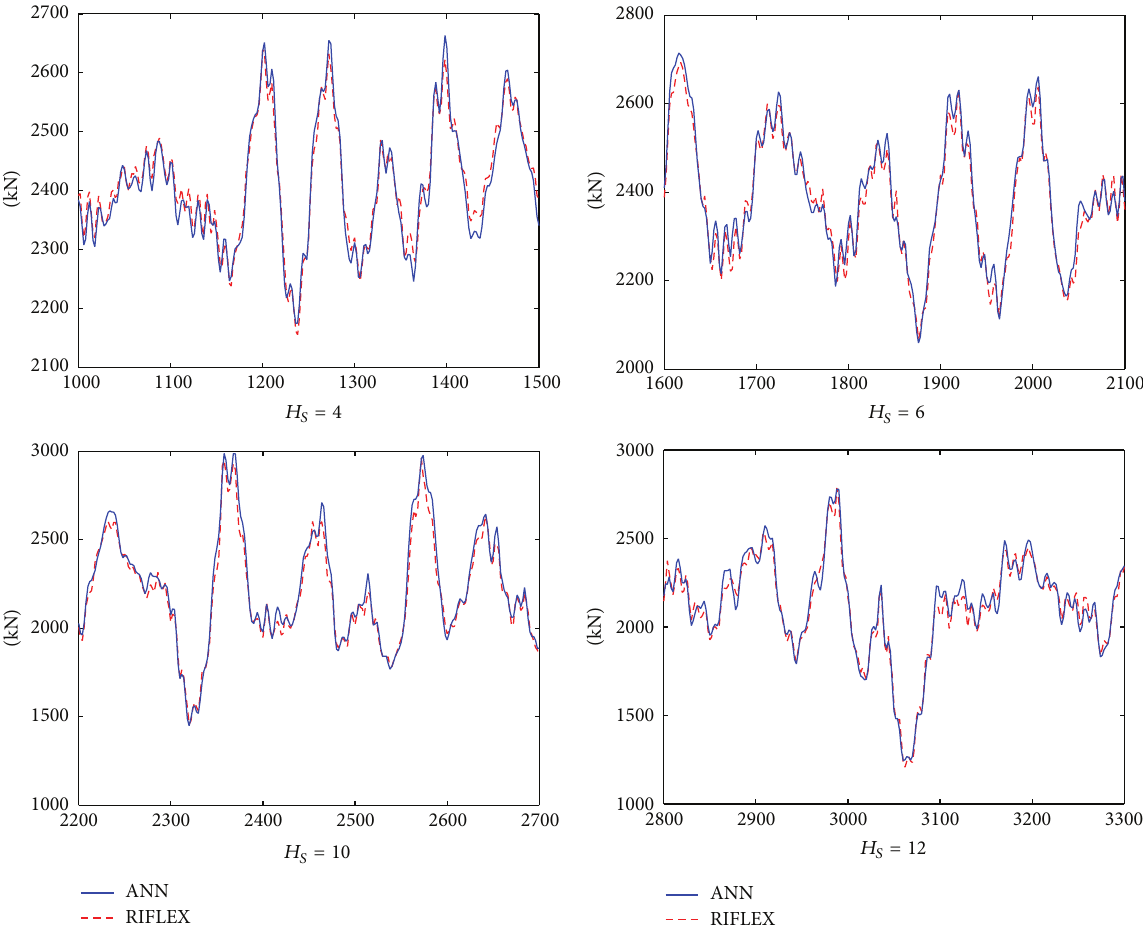
Figure 9: Comparison of simulated top tension forces using ANN and RIFLEX for the four wave heights that were not part of the network training.